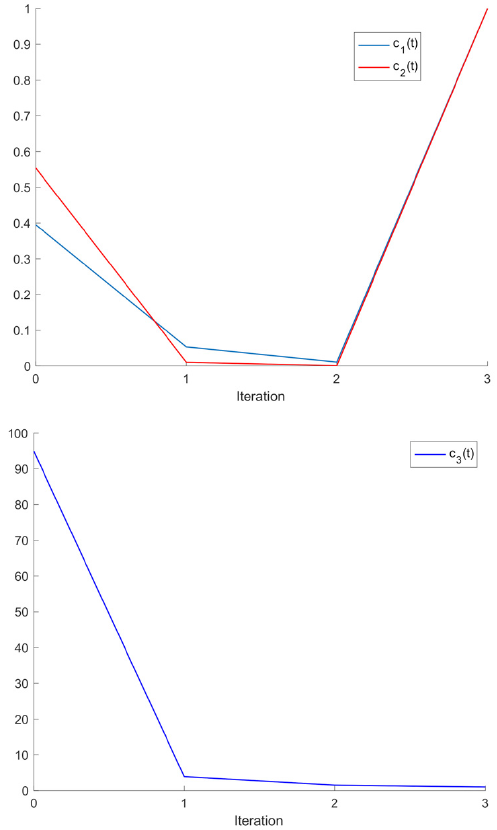
Figure 6. Demands vector in Example